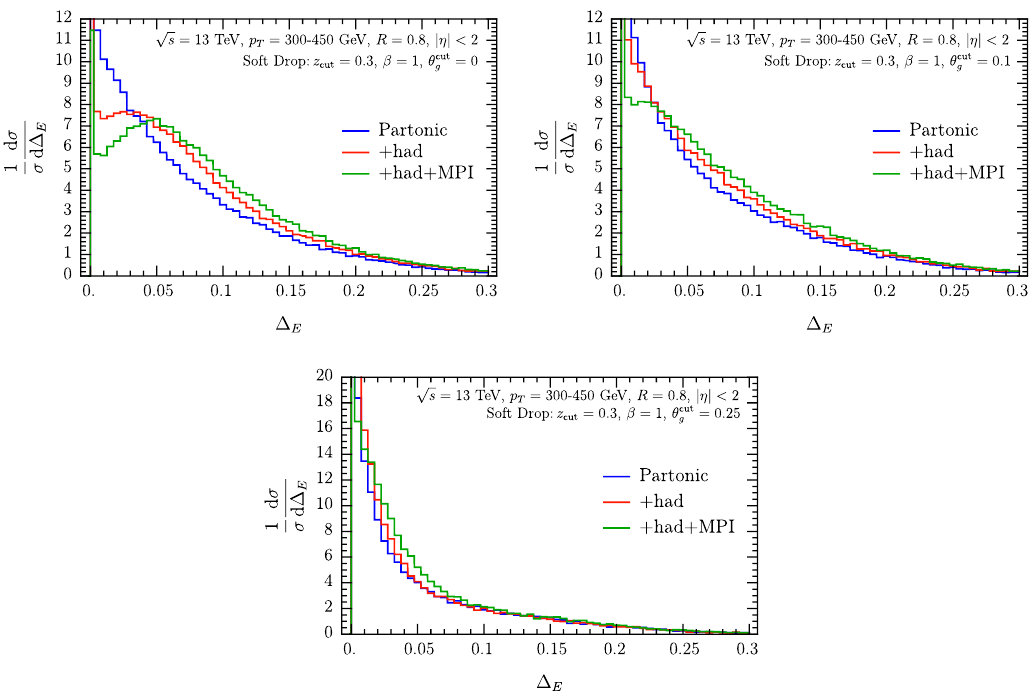
Figure 17 . Pythia results for the jet energy drop with soft drop at parton level (blue) and including hadronization (red) and MPI (green). The three panels correspond to θ cut 0.1 (top right), 0.25 (bottom). Note that these curves are normalized on the full ∆ E interval.